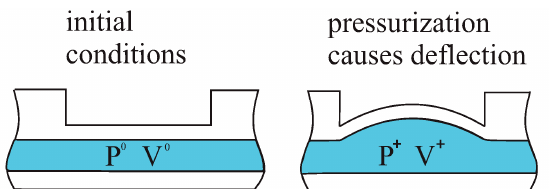
Figure 3. Pressurized storage chamber: The deflection of the thin membrane can be used to measure the stored volume. To release the drug the preloaded membrane can be used to push the drug into the body.